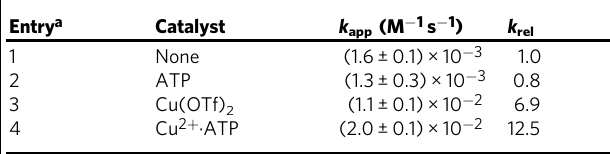
Table 2 Kinetic study of Cu 2 + ·ATP.